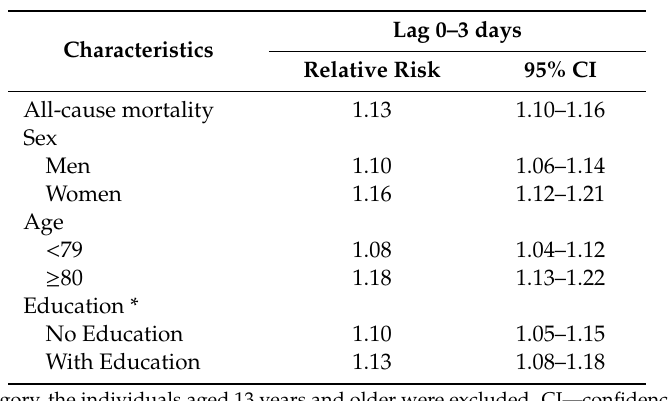
Table 3. Citywide relative risk of all-cause mortality related to summer extreme temperatures by sex, age and education during the study period 1992–2015 in Barcelona.